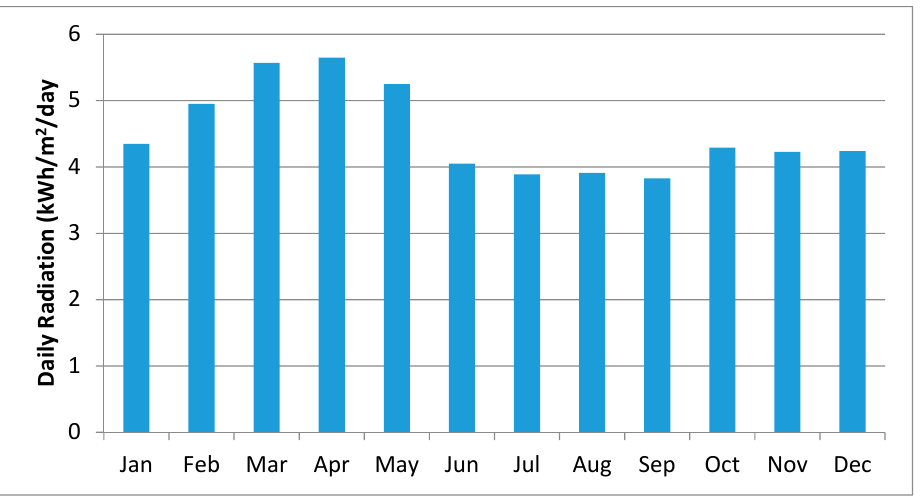
Figure 7. Monthly average solar irradiation in the study area.